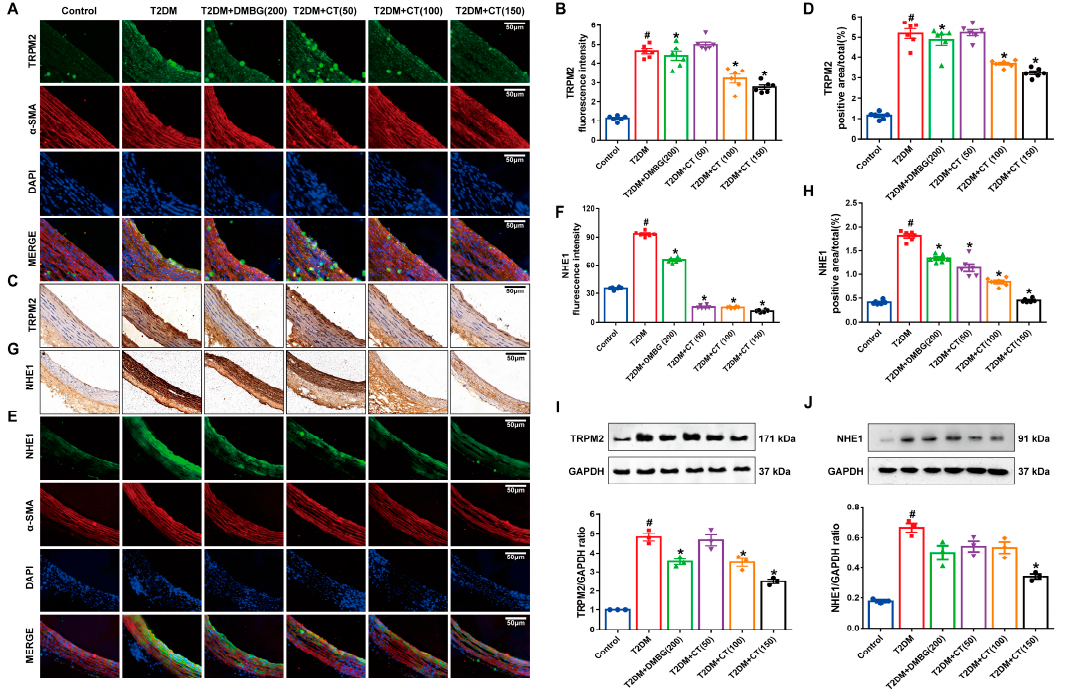
Figure 4. CT suppressed the protein expression of TRPM2 and NHE1 in carotid arteries of T2DM rats. ( A ) The immunofluorescence detection of TRPM2 in carotid arteries (TRPM2, green ; α -SMA, red ). ( B